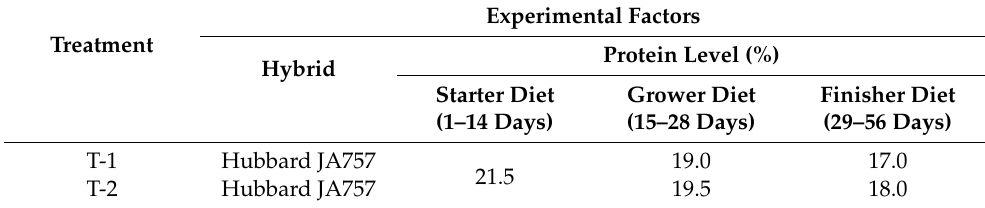
Table 1. Experimental